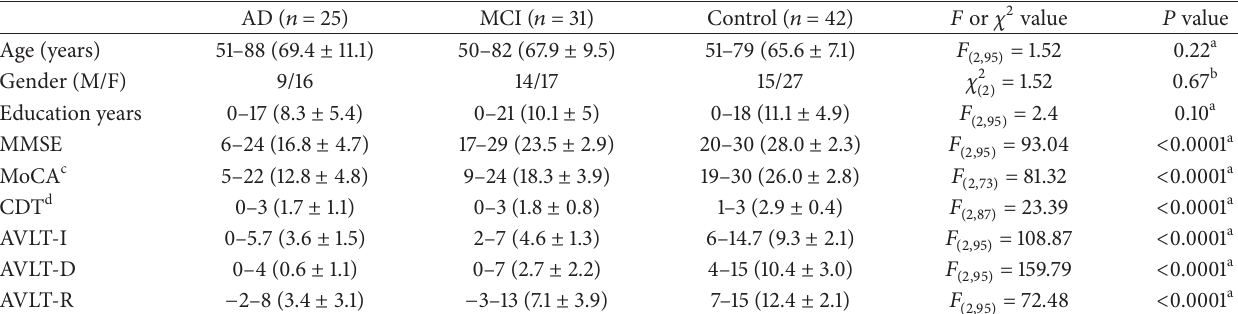
Table 1: Demographics and clinical characteristics of the